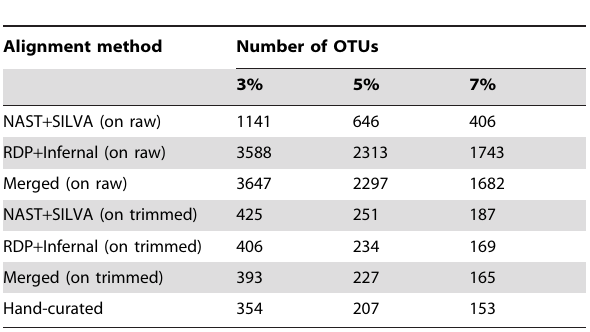
Table 1. Dependence of the number of OTUs on the alignment method used. The percentages indicate clustering radius.